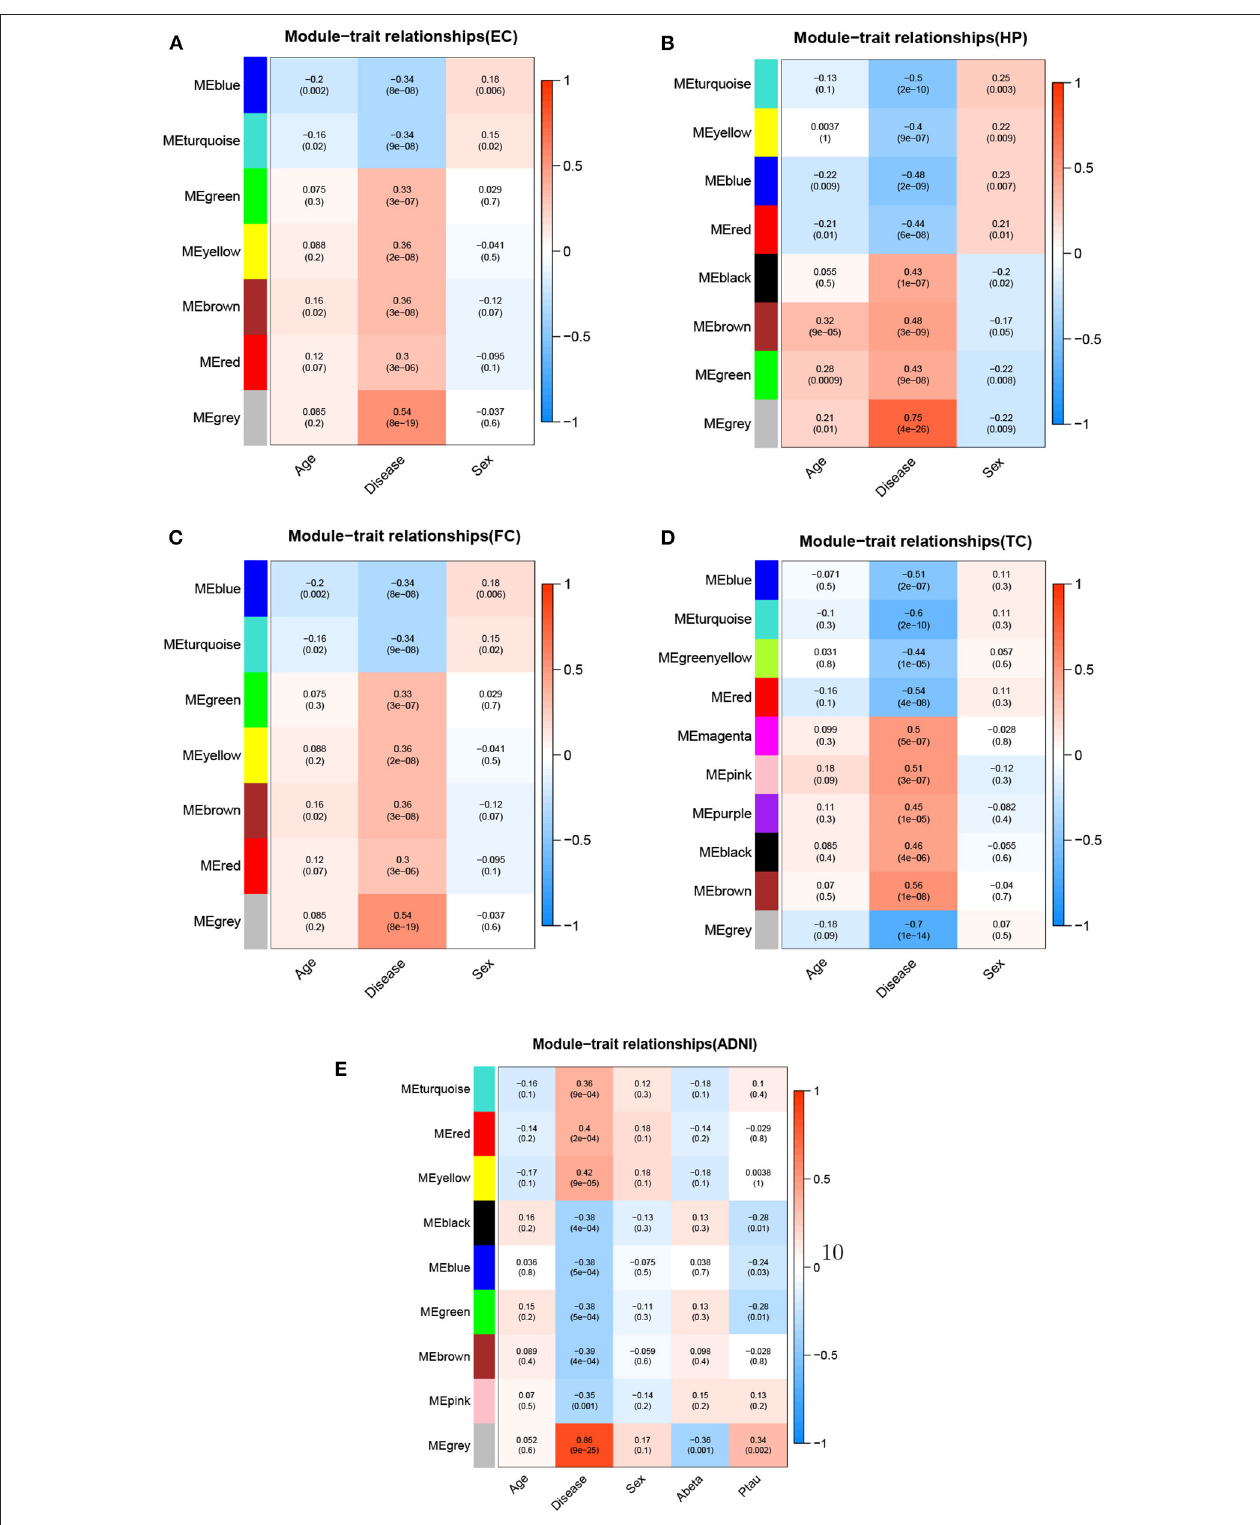
FIGURE 6 | Module-trait relationships for five datasets.Each row represents different gene co-expression modules, and each column represents different clinical phenotypes. Number represent correlation coefficients and P-values are in parenthesis. Correlation strength is represented by continuous color, with red being positive, blue being negative. (A) EC, (B) HP, (C) FC, (D) TC, and (E) ADNI.